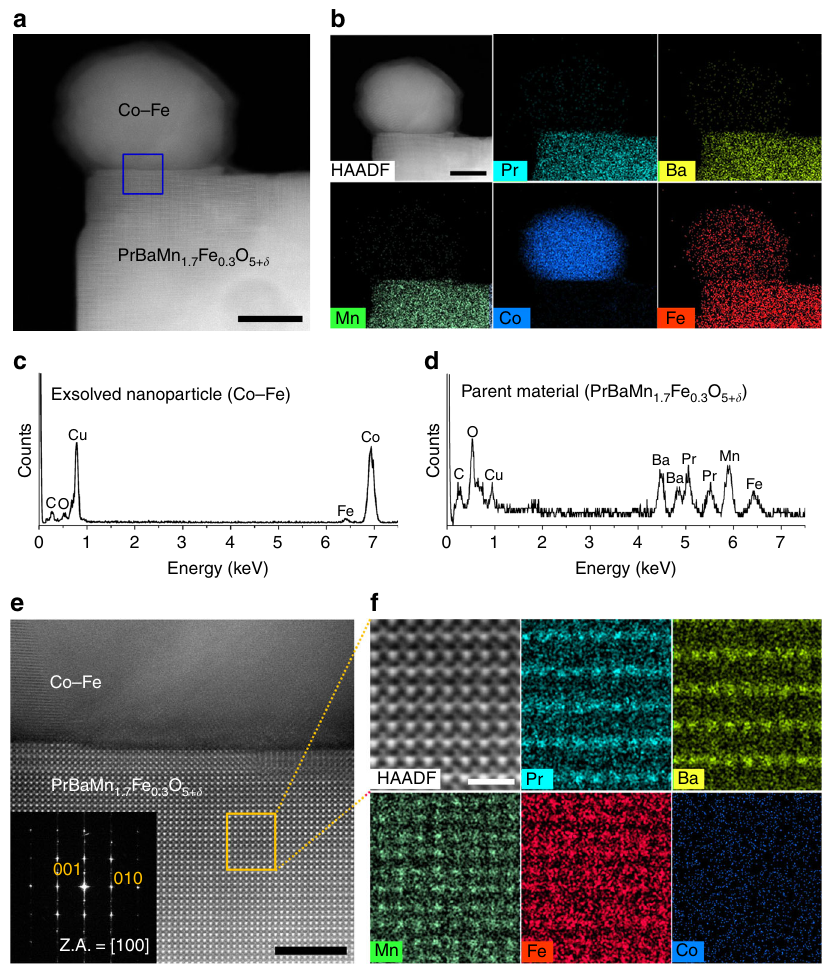
Fig. 3 Transmission electron microscopy of exsolved particles and parent material. a HAADF scanning TEM image of PBMCo-12-Fe. b EDS elemental map of Pr, Ba, Mn, Co, and Fe; scale bar 20 nm. c EDS spectrum of the exsolved nanoparticles. d EDS spectrum of the parent material of PBMCo-12-Fe. e HAADF scanning TEM image of PBMCo-12-Fe (blue square in Fig. 3a) and the corresponding fast-Fourier transformed pattern with zone axis =